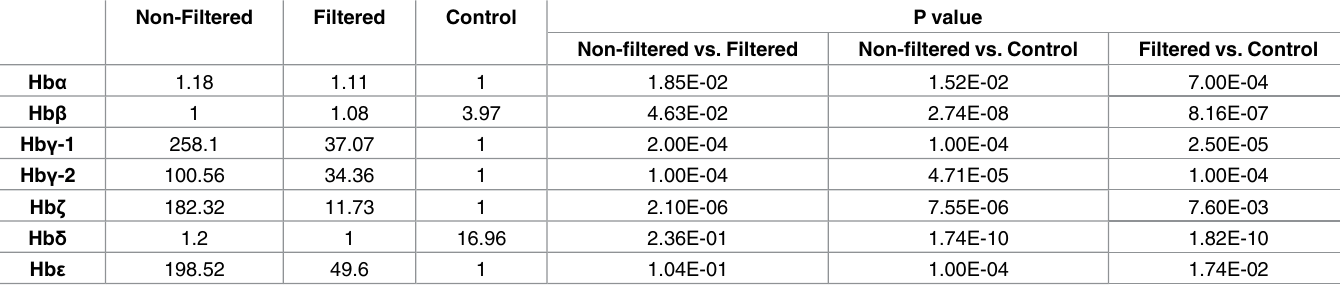
sues. We observed similar 2,3-DPG levels in non-filtered (NF) and filtered (F) stemRBCs Table 2. Fold change comparison of hemoglobin subunits between stemRBCand control RBC. Non-filteredand filtered stemRBC on day 18 of culture along with human control RBCs. Mean, (n = 3). Non-Filtered Filtered Control P value Non-filtered vs. Filtered Non-filtered vs. Control Filtered vs.